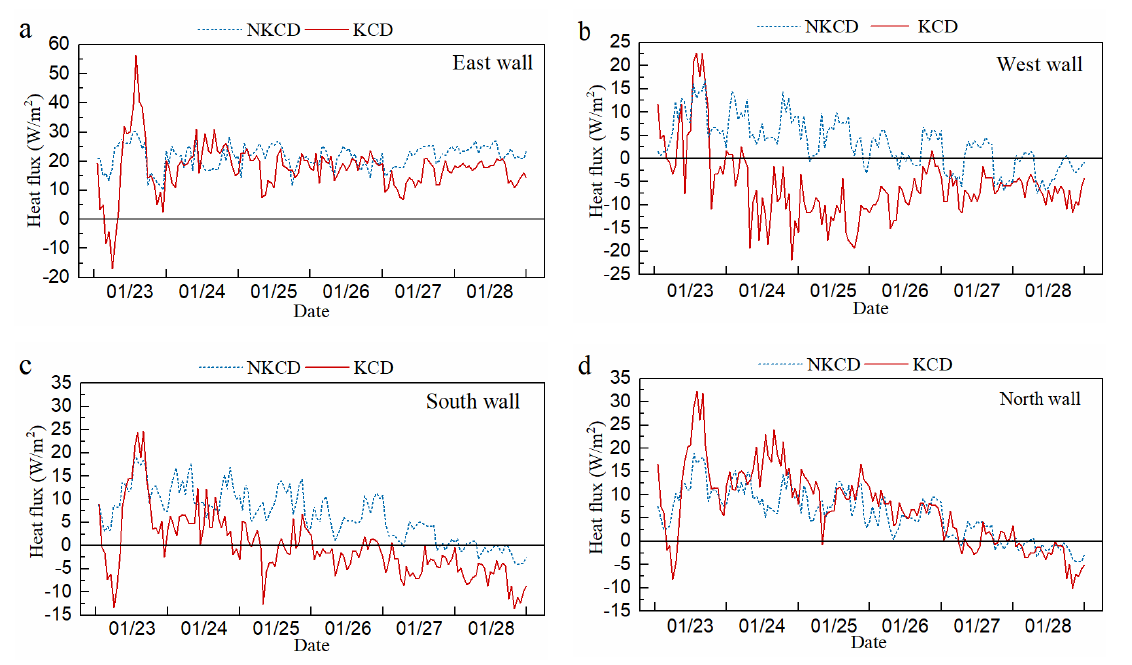
Figure 15. Heat flux of inner surface: ( a ) east external wall; ( b ) west internal wall; ( c ) south side wall; ( d ) north side wall.